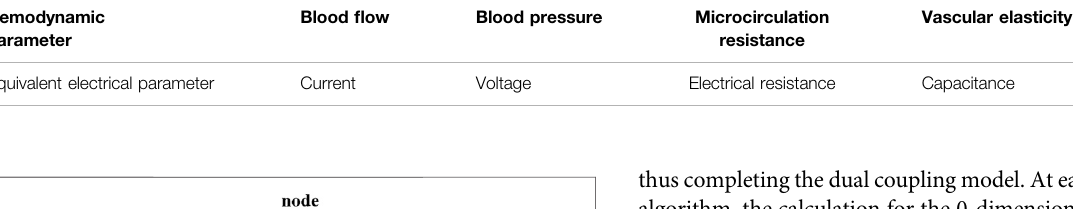
TABLE 1 | Hemodynamic parameters and equivalent electrical parameters. Hemodynamic